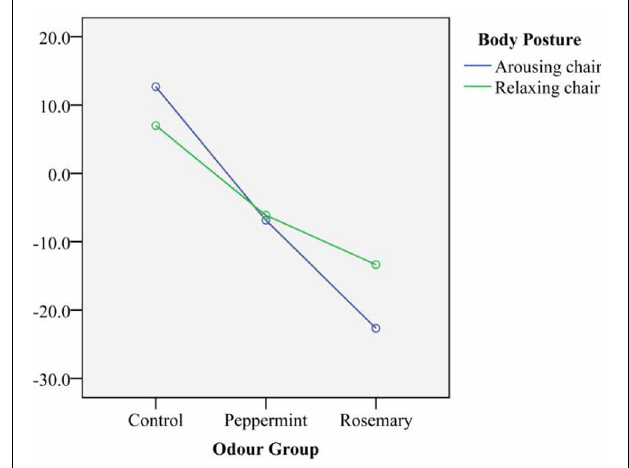
FIGURE 1 | Over-underproductions in seconds per odor group and body